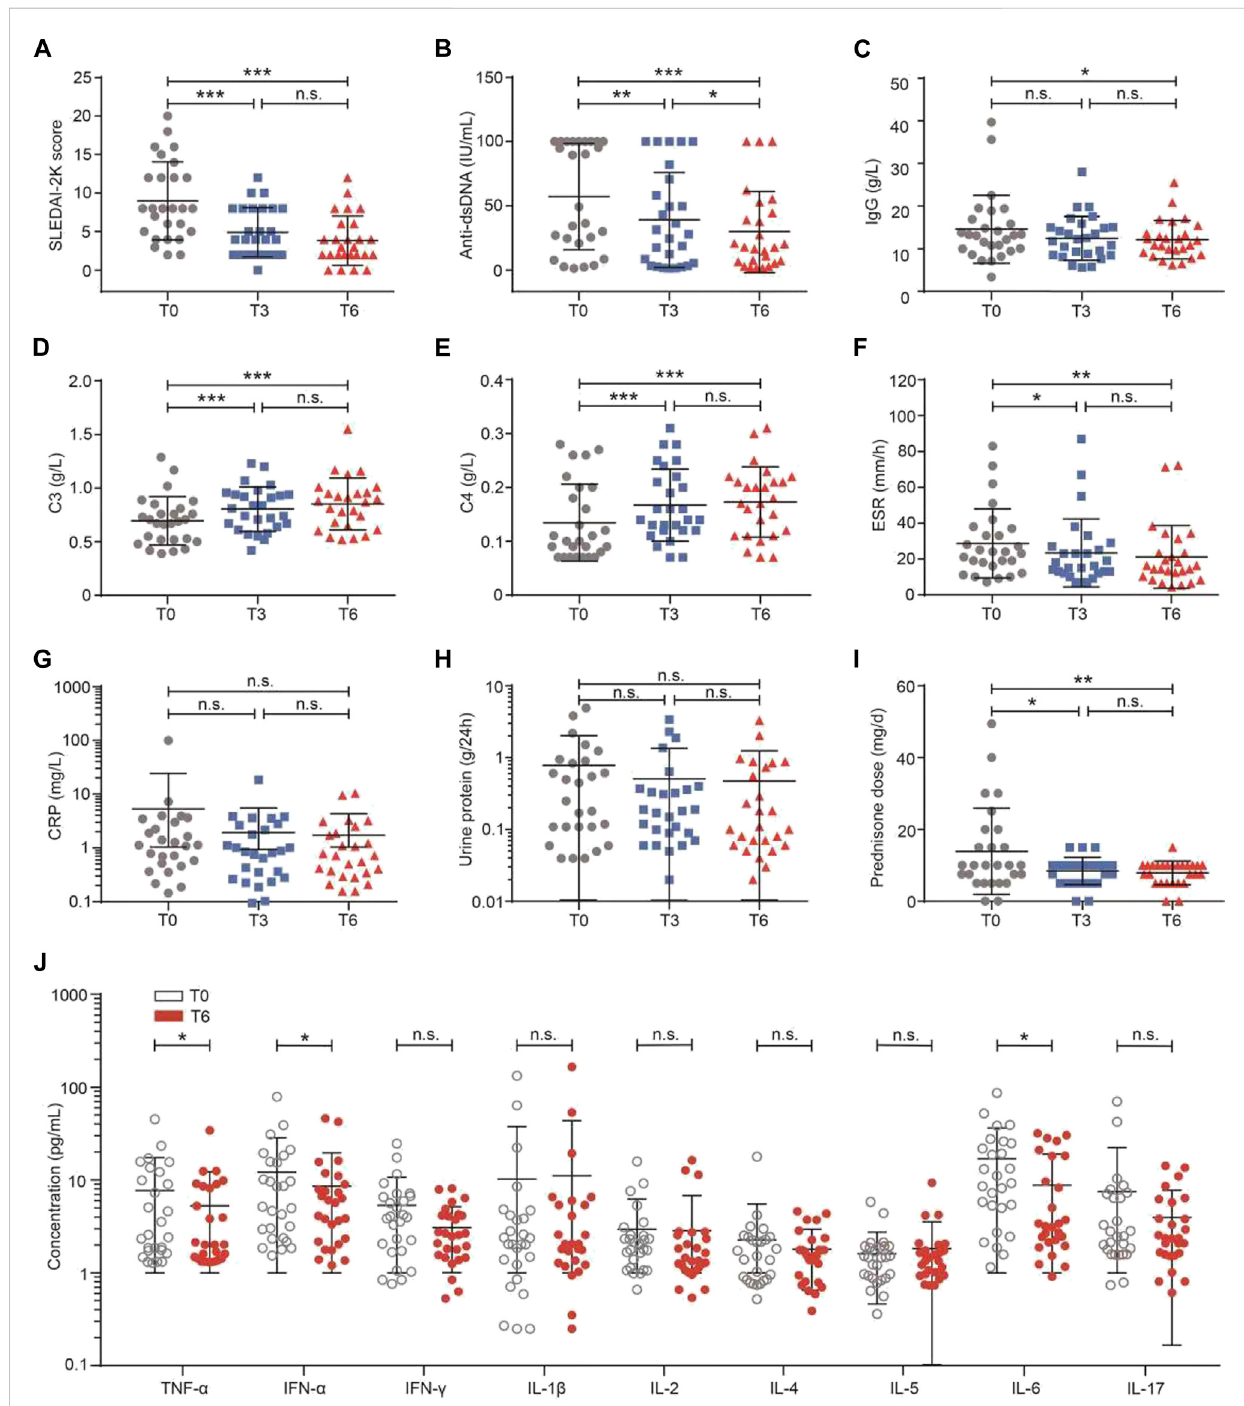
FIGURE 2 Effects of belimumab treatment on clinical markers in the patients with SLE. (A – J) Change in the SLEDAI-2K score, anti-dsDNA, IgG, complement C3,complementC4,ESR,CRP,24-hurineprotein,doseofprednisone,andlevelsofin fl ammationcytokines.Abbreviations:CRP,C-reactiveprotein;DN, double-negative; ESR, erythrocyte sedimentation rate; SLE, systemic lupus erythematosus; SLEDAI-2K, SLE Disease Activity Index 2000; T,